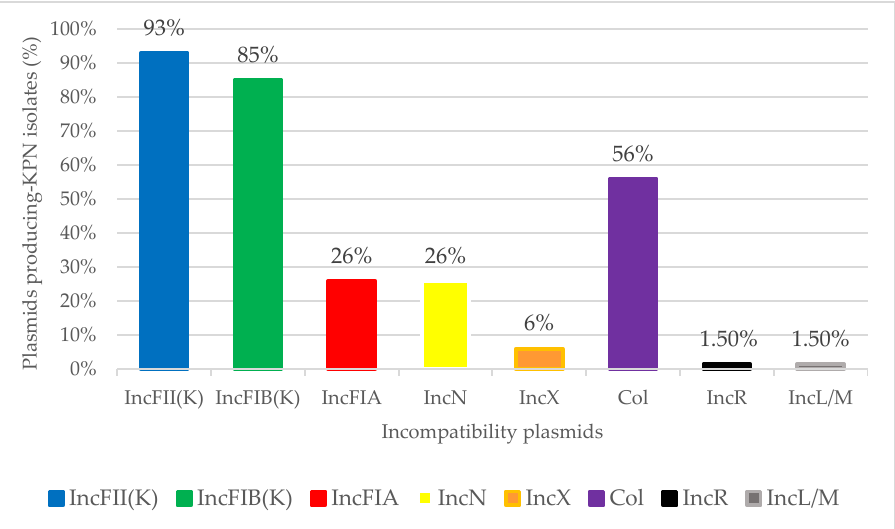
Figure 2. Distribution of incompatibility plasmids found in 68 K. pneumoniae isolated from residents of twelve LTCFs (Northern